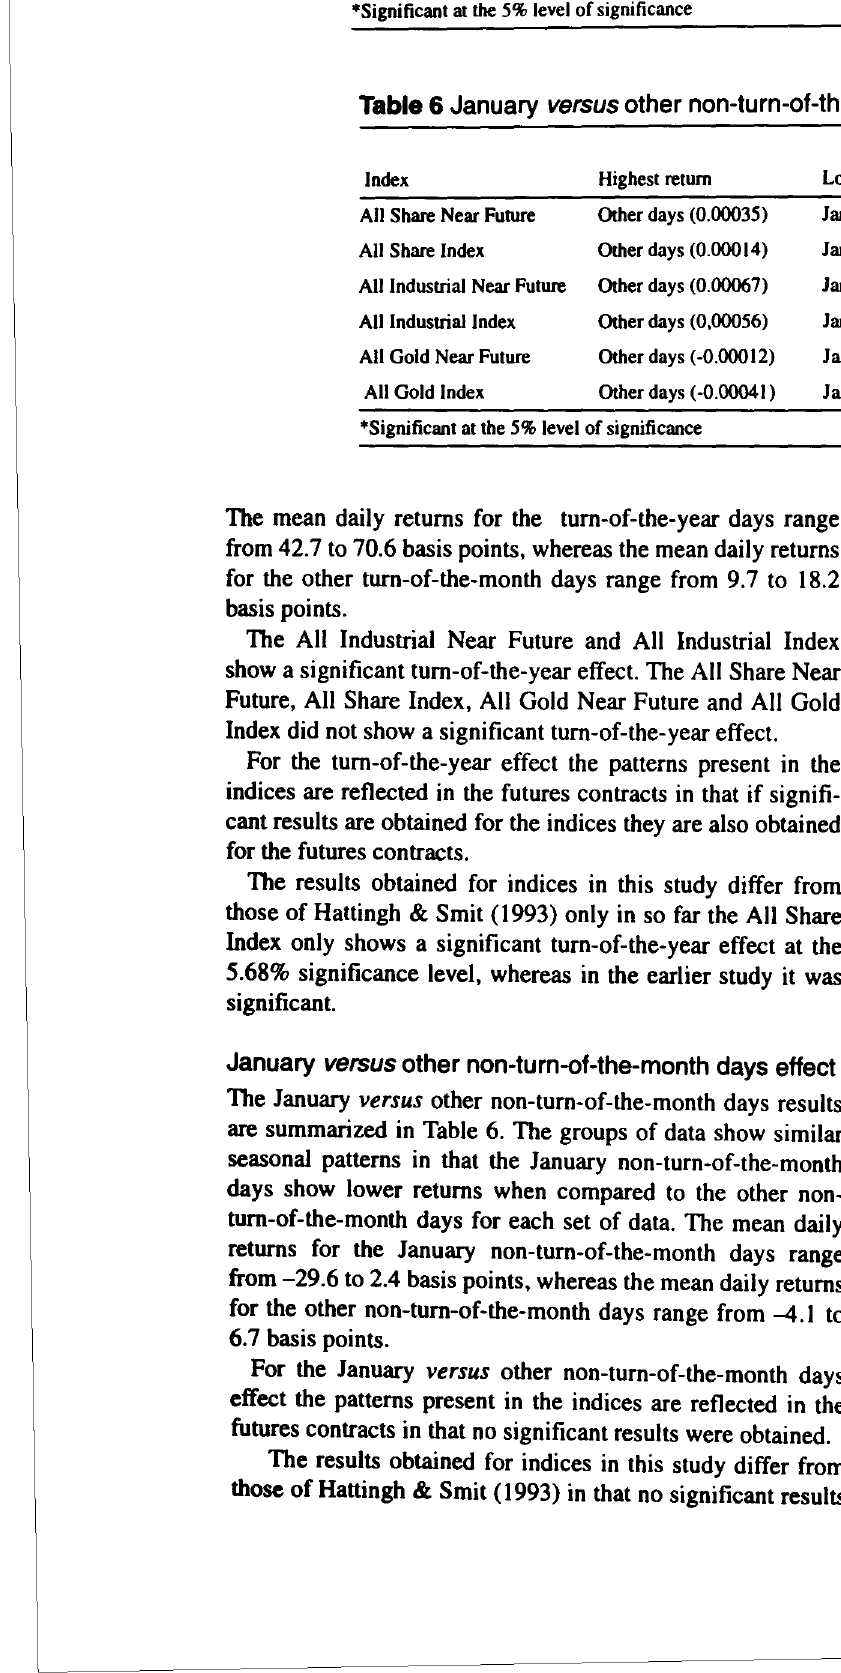
Table 6 January versus other non-turn-of-the-month days effect